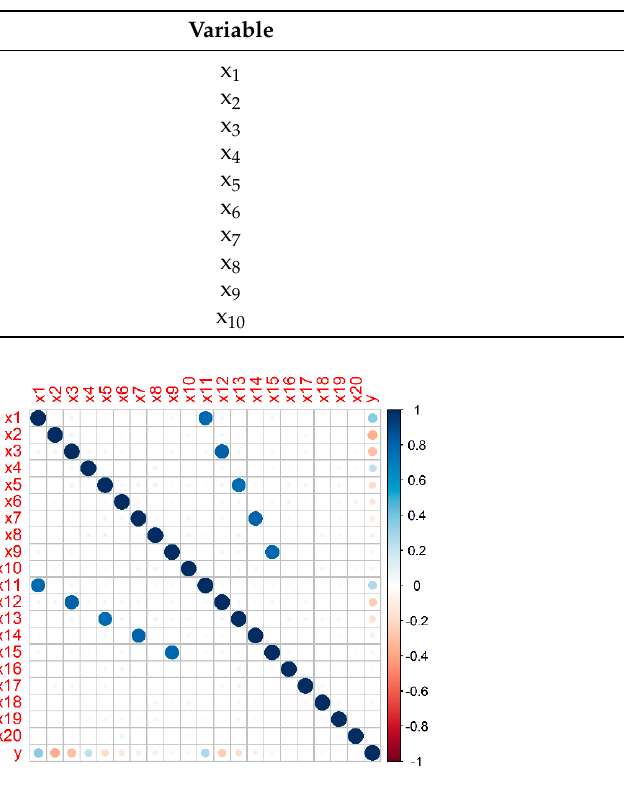
Figure 1. Pearson correlation matrix of the representative simulated dataset. The variables x 1 -x 20 are the simulated candidate predictors, y represents the event times before applying the censoring. Table 1. Coefficients of the true Cox model for the representative simulated dataset.